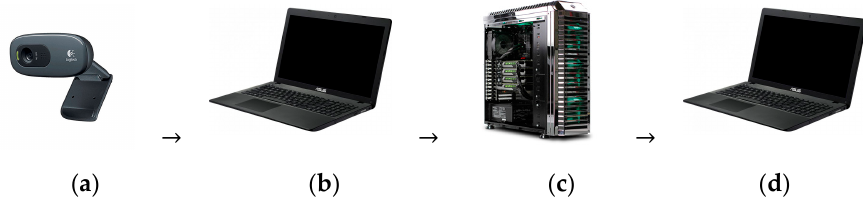
Figure 5. Flowchart 1: relationship between different machines. ( a ) camera; ( b ) data acquisition device; ( c ) processor; ( d ) display.